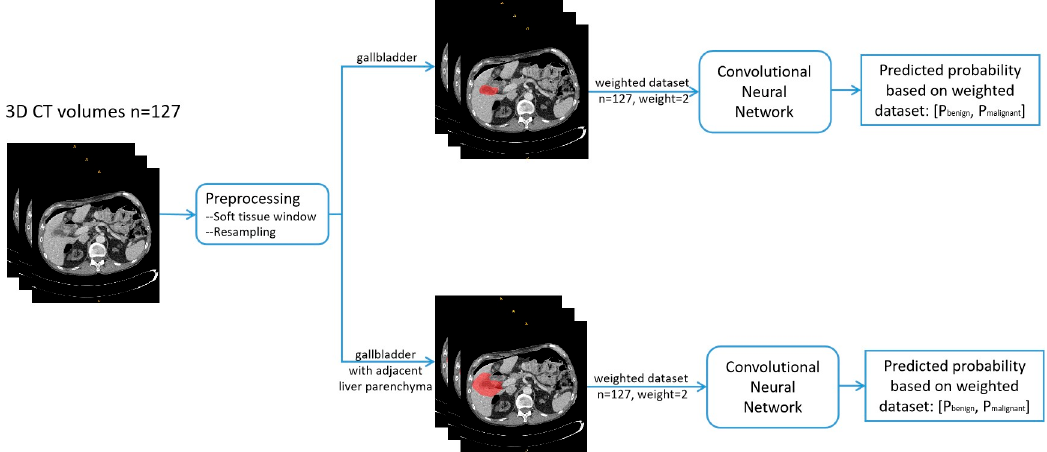
Figure 1. Workflow of the convolutional neural network for gallbladder cancer and benign gallbladder disease differentiation.